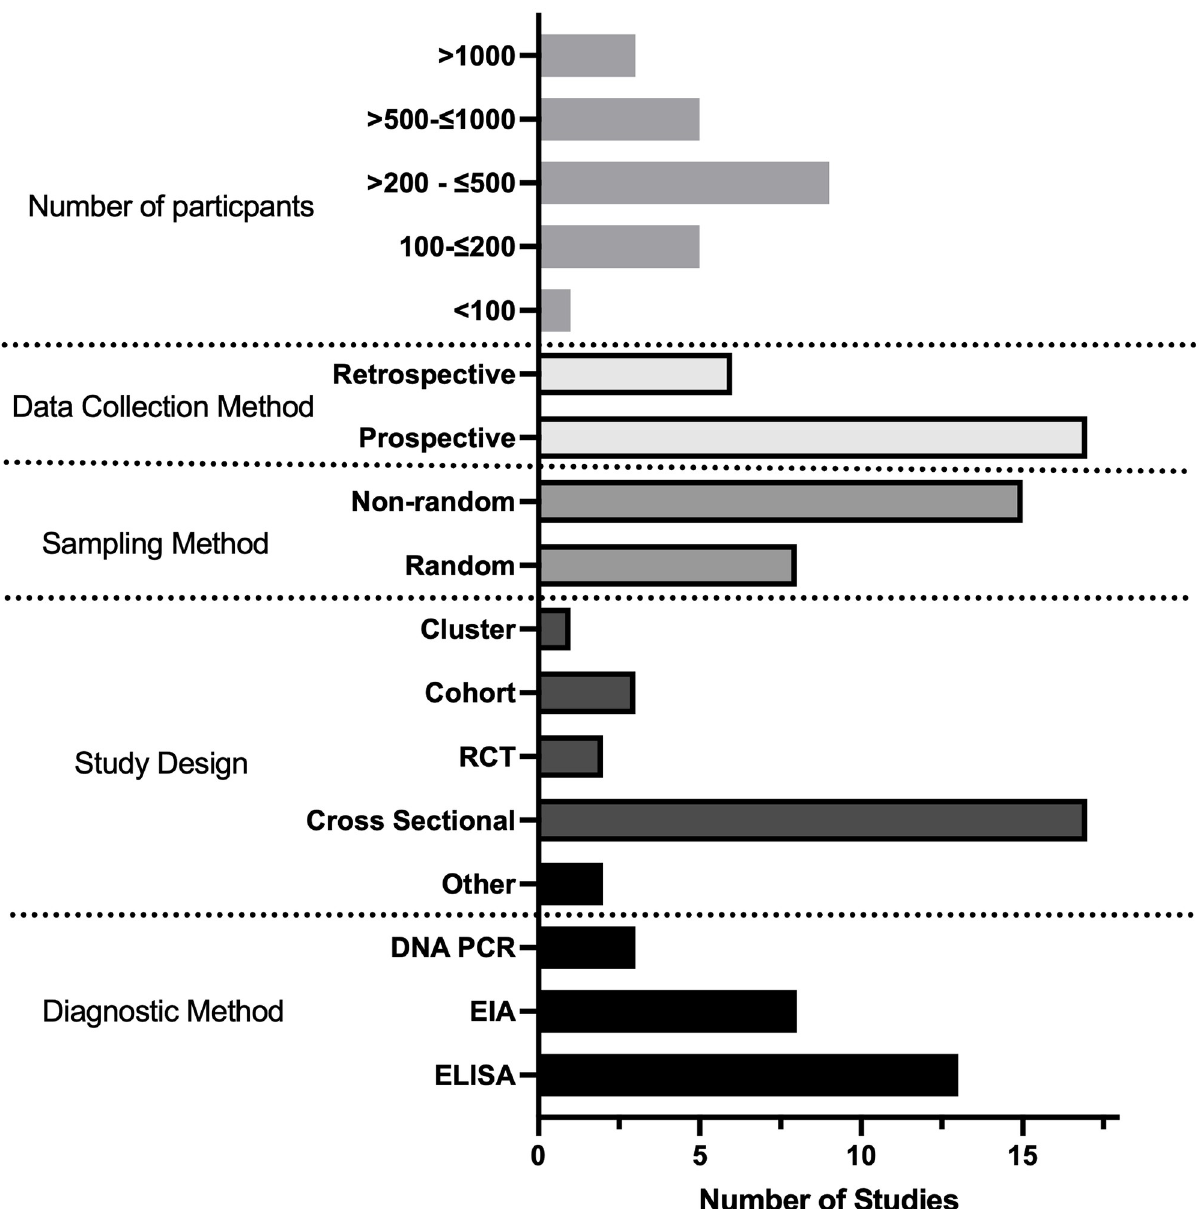
Fig 3. Bar chart showing characteristics of studies identified for a systematic review reporting prevalence and genetic data for HBV in Kenya. This is stratified by number of participants, study design, sampling method, data collection and diagnostic methods. RCT: Randomised controlled trial; EIA: Chemiluminescent enzyme immunoassay; ELISA: Enzyme linked immunosorbent assay.